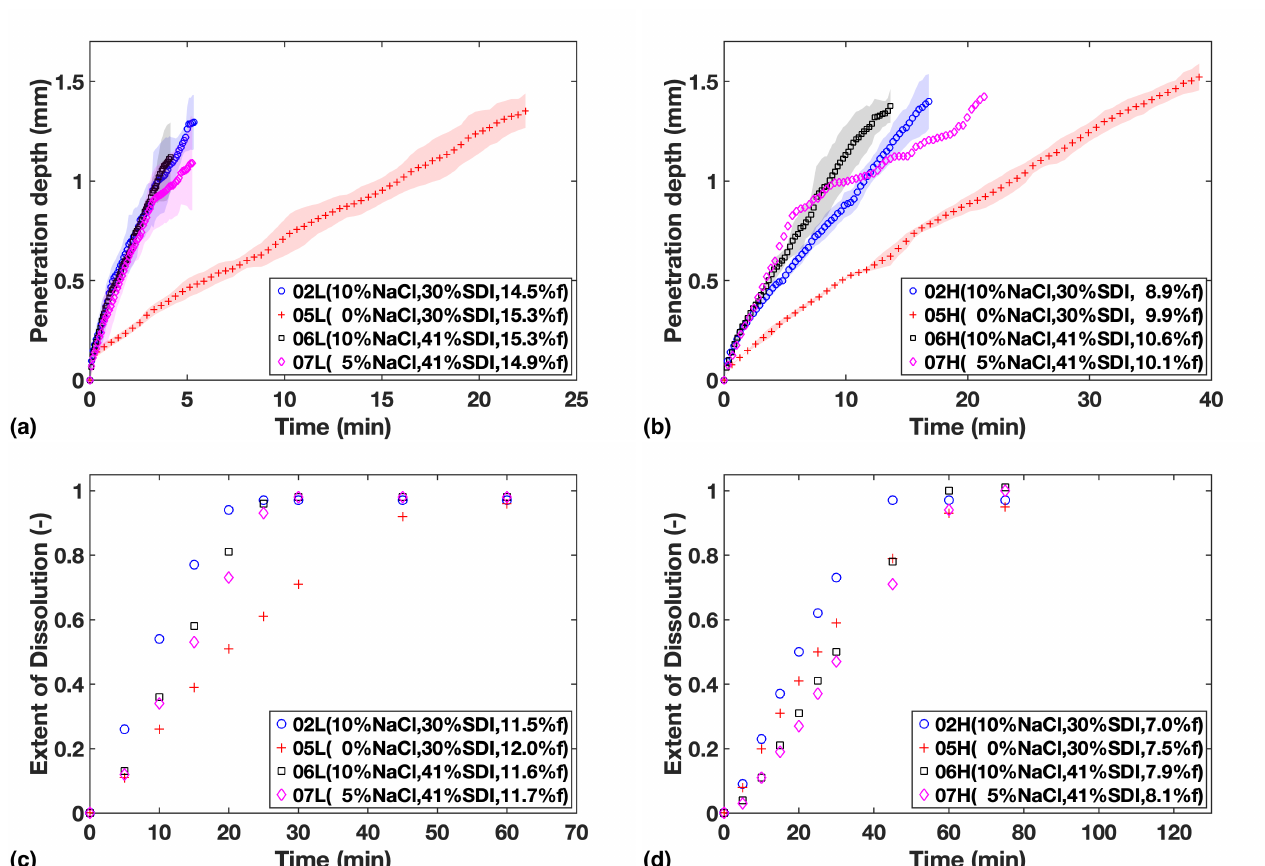
Figure 3. Study 2—Liquid penetration vs. time from TPI data for ( a ) Low compaction batches ( b ) High compaction batches, which is to be compared with USP dissolution profiles for ( c ) Low compaction batches ( d ) High compaction batches. Mass fraction of NaCl, SDI and mean batch porosity labelled in the